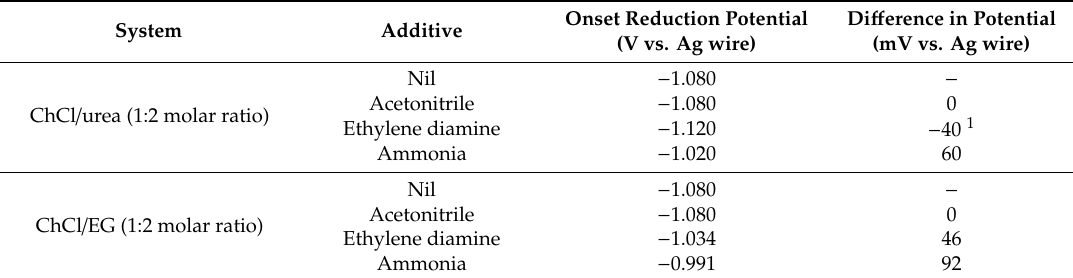
Table 2. The onset in reduction potential for the Zn deposition in deep eutectic solvents using di ff erent additives